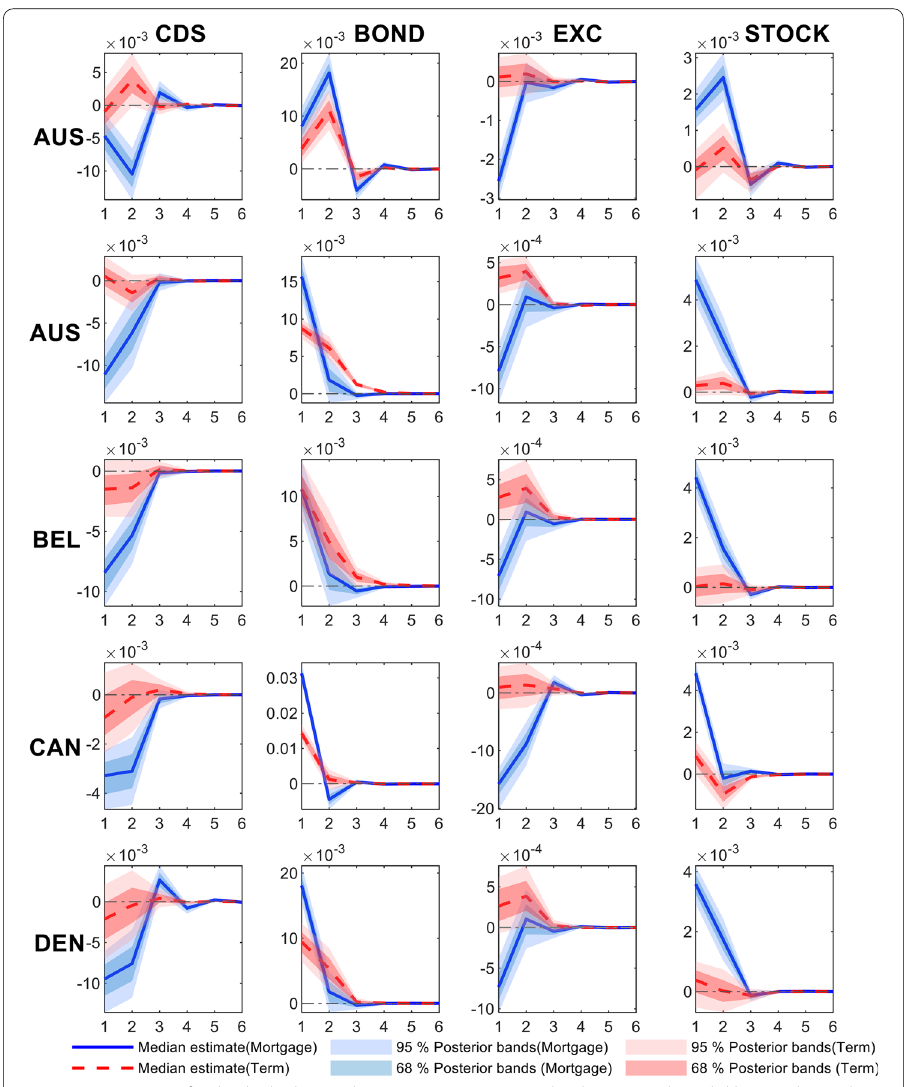
Fig. 14 Responses of individual advanced economies to US UMP shocks. Notes: The solid lines indicate the median estimate of the responses to a one standard deviation decline in US mortgage spread while the dashed lines show the median estimate of the responses to a one standard deviation decline in US term spread. Dark (light) shaded areas represent the 68% (95%) posterior probability bands. The posterior bands are based on 10.000 accepted draws, of which we discard the first 2.000 as burn-in